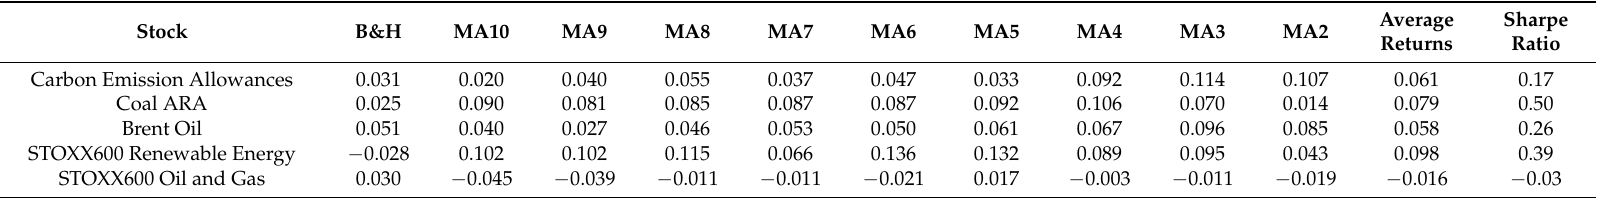
Table A3. Annualized daily (every 22nd trading day) returns of MA2–MA10, average returns and Sharpe